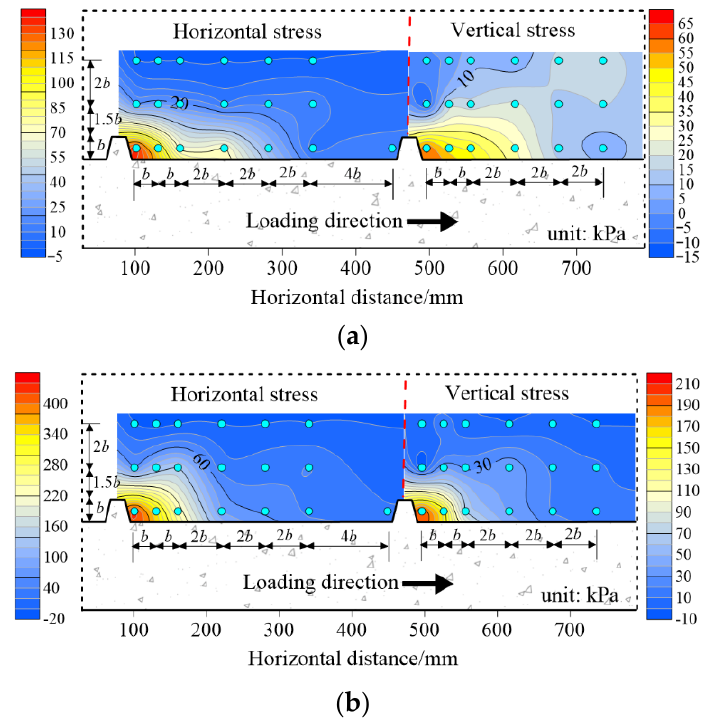
Figure 13. Final soil stress distribution of the 12 b screw shear plate. ( a ) 40 kPa and ( b ) 120 kPa.